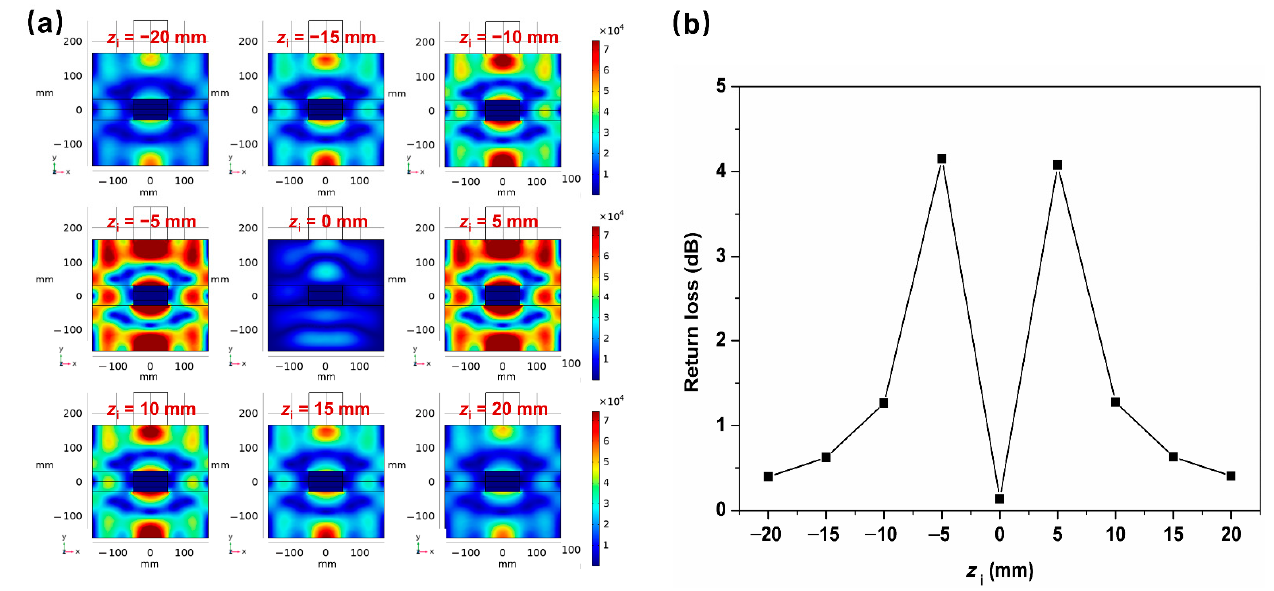
Figure 3. Effect of irradiation feed position on the simulated electric fields (the electric field unit: V/m; x – y plane, z = 0; P = 1000 W; l SiC = 100 mm; v = 0.02 m/s): ( a ) variation of the electric fields with different irradiation feed positions; and ( b ) the microwave return loss with different irradiation feed positions.